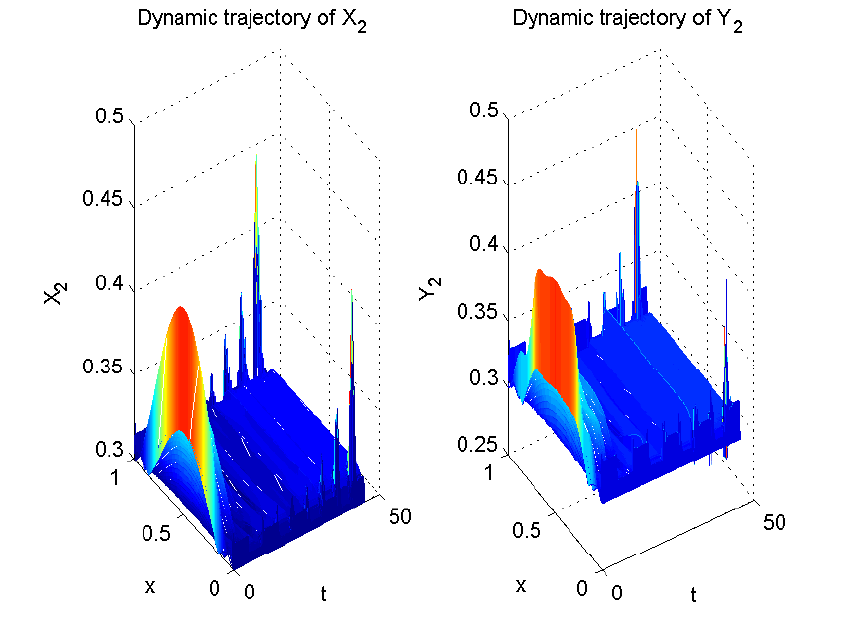
Figure 2. Computer simulation of X 2 in (3) and Y 2 in (5).